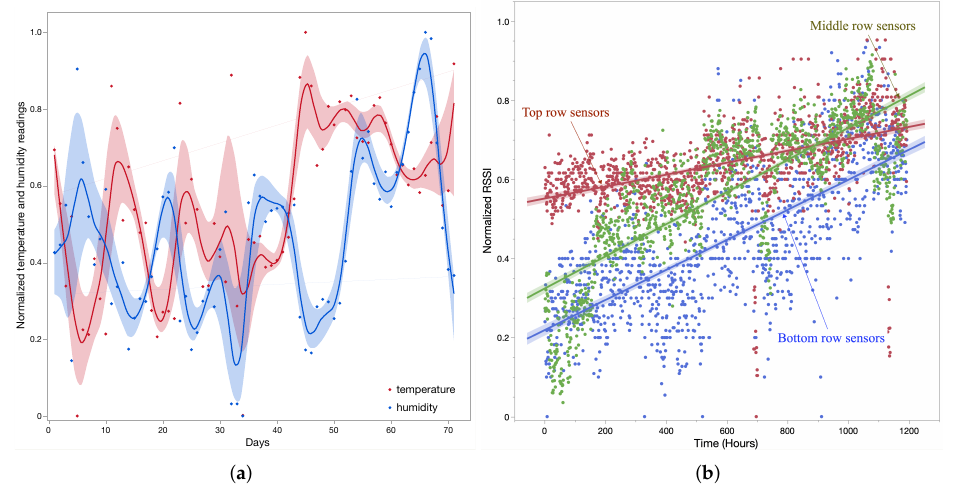
Figure 12. Data analysis from all sets of readings captured by the sensors in the greenhouse. ( a ) In- verse relation between temperature and humidity; ( b ) Impact on RSSI from set of sensors deployed in different rows inside the